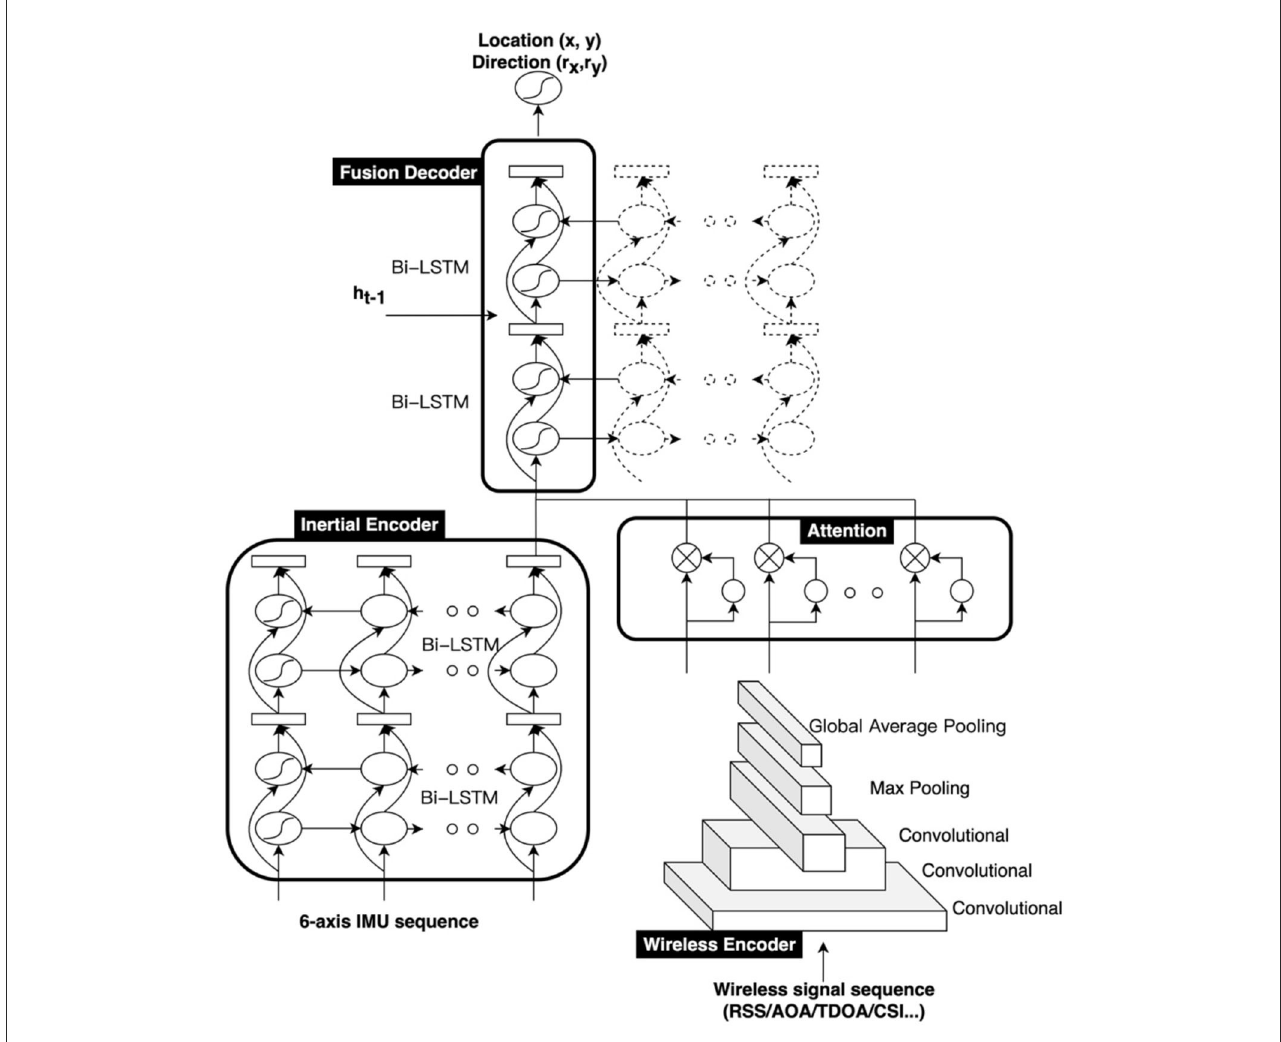
FIGURE1 Architecture of